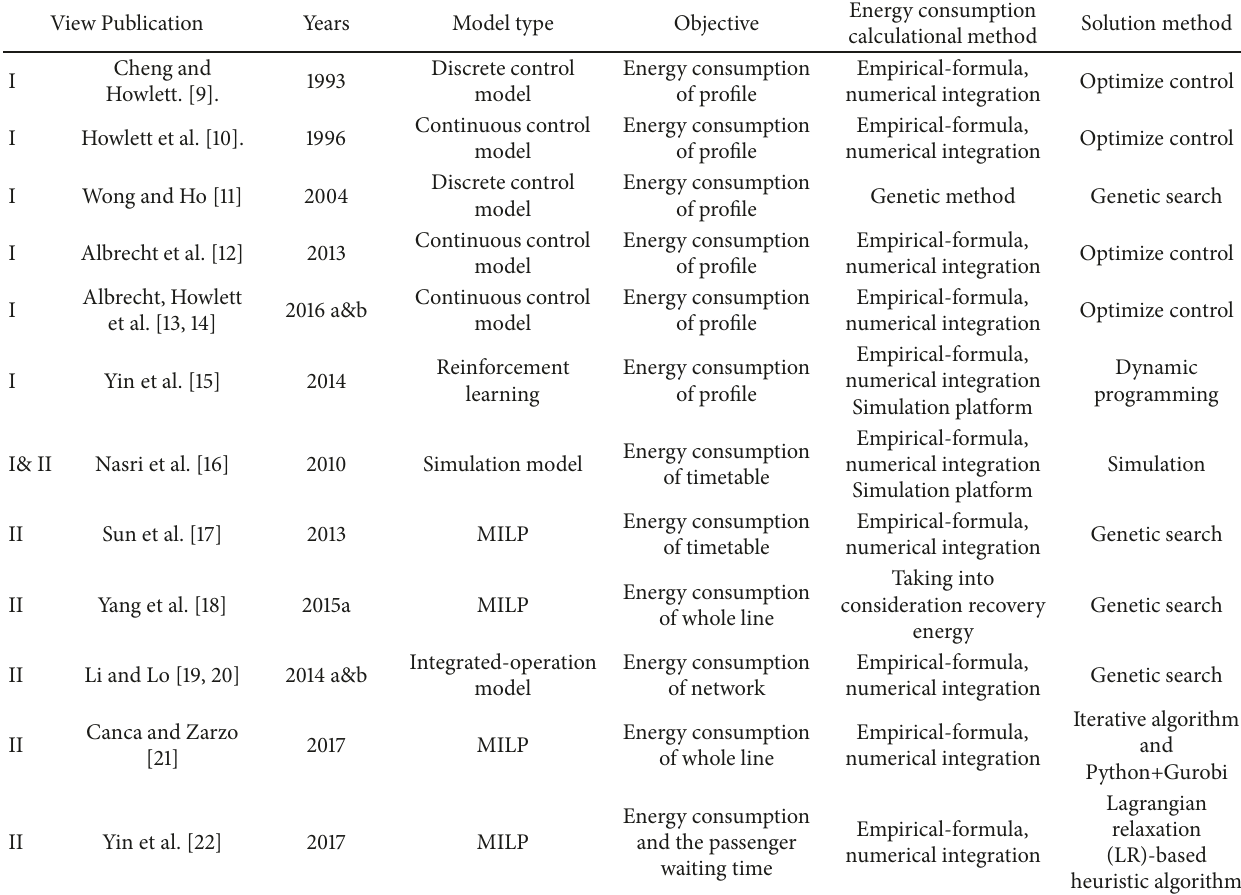
Table 1: Some typical publications about